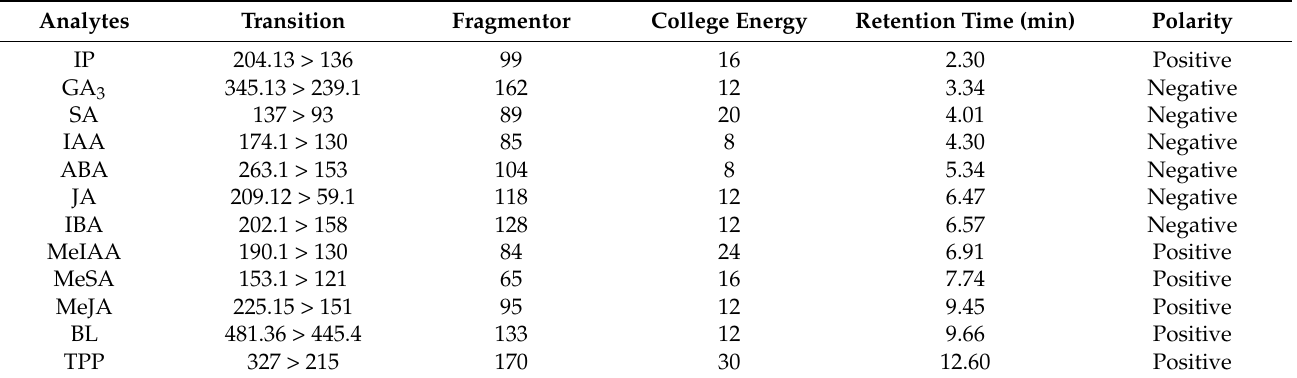
Table 1. The MRM parameters of 11 hormones and an internal